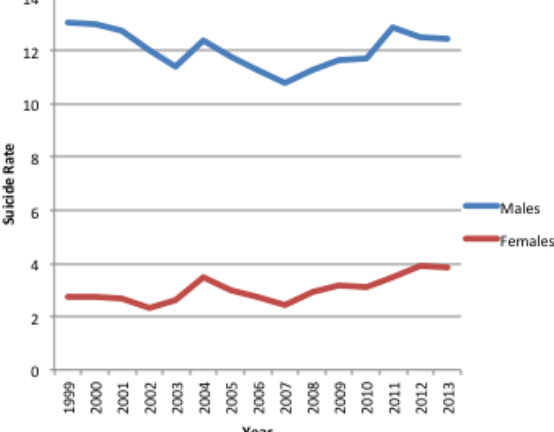
Figure 5. Rates per 100,000 of suicide deaths in adoles- cents from 1999 to 2013 in US. Source: Centers for Dis- ease Control and Prevention